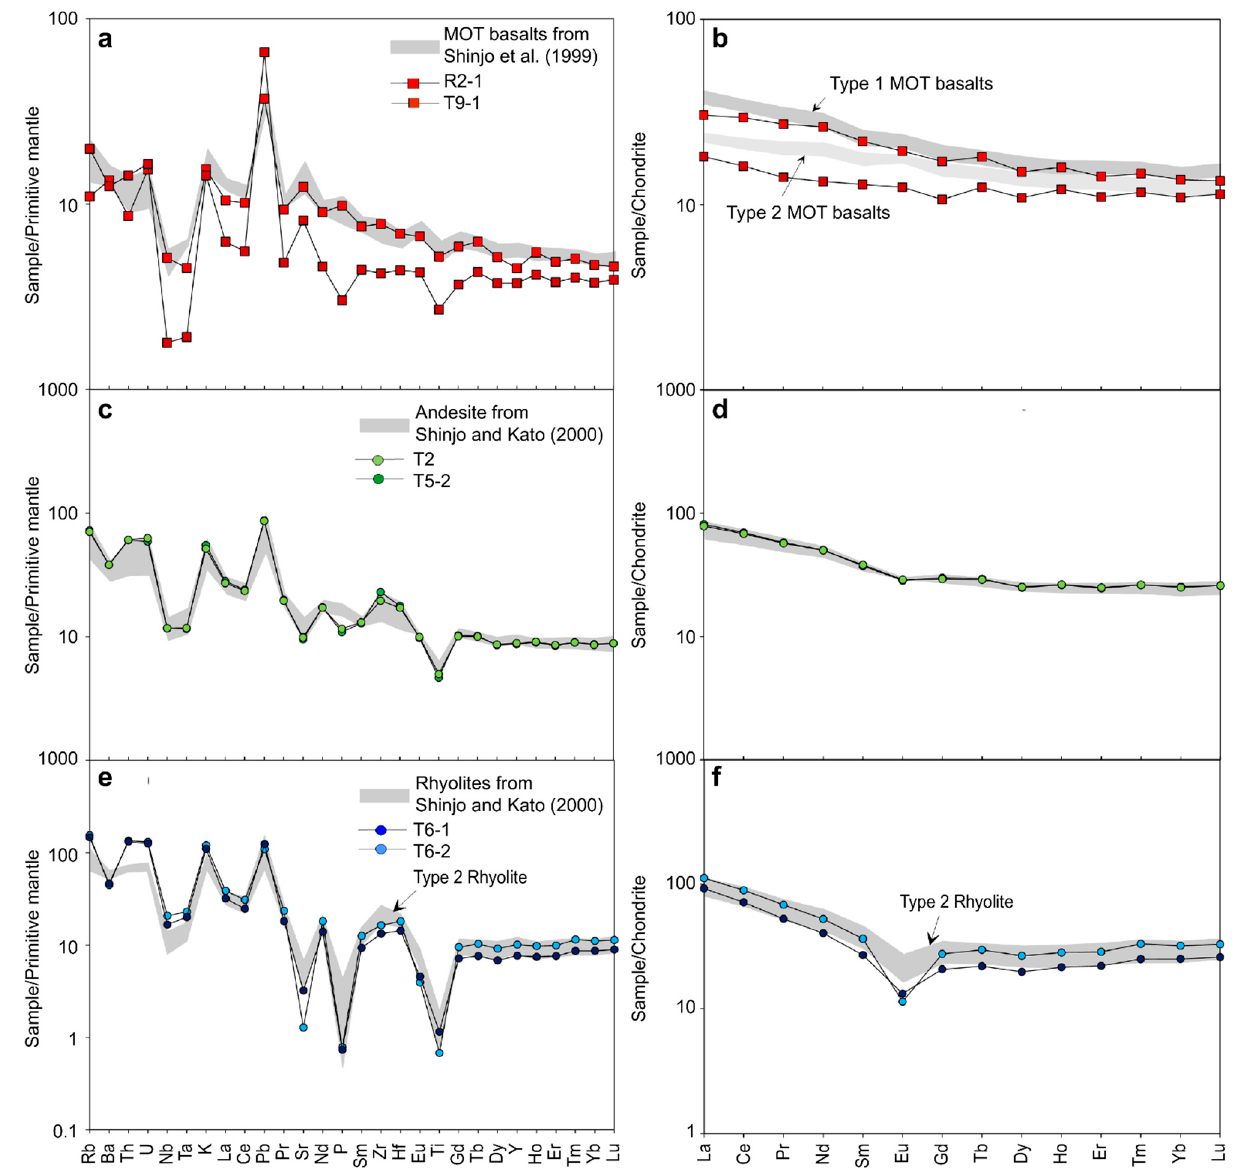
Figure 4. ( a , c , e ) Trace element patterns normalized to primitive mantle and ( b , d , f ) corresponding rare earth element (REE) patterns normalized to chondritic contents for the MOT and SOT volcanic lavas. Primitive mantle and chondrite contents are from [90]. ( a , b ) show the trace element distributions of the MOT basalt and the SOT basaltic andesite, respectively. ( c , d ) show the trace element distributions of the MOT andesite and trachyandesite, respectively. ( e , f ) show the trace element distributions of the MOT rhyolites. Data are from [50,73], and this study. In addition, the Li isotope fractionations ( ∆ 7 Li x − y = δ 7 Li x − δ 7 Li y ) between coexisting mineral phases ( x - y ) were also calculated. The ∆ 7 Li cpx-ol (Li isotope fractionation between coexisting clinopyroxene and olivine) and ∆ 7 Li pl-ol (Li isotope fractionation between coex- isting plagioclase and olivine) values of the R2 basalt from the MOT were − 3.76 and − 3.77, respectively. The ∆ 7 Li cpx-ol , ∆ 7 Li opx-ol , and ∆ 7 Li pl-ol values of the T5-2 trachyandesite from the MOT were − 3.24, − 0.07, and − 0.55, respectively. The ∆ 7 Li cpx-ol , ∆ 7 Li opx-ol , and ∆ 7 Li − 2.35, − 1.80, and − 7.88, pl-ol values of the T9-1 basaltic andesite from the SOT were respectively. The ∆ 7 Li values of all samples were negative. This cannot be explained by closed system equilibrium between the different minerals and